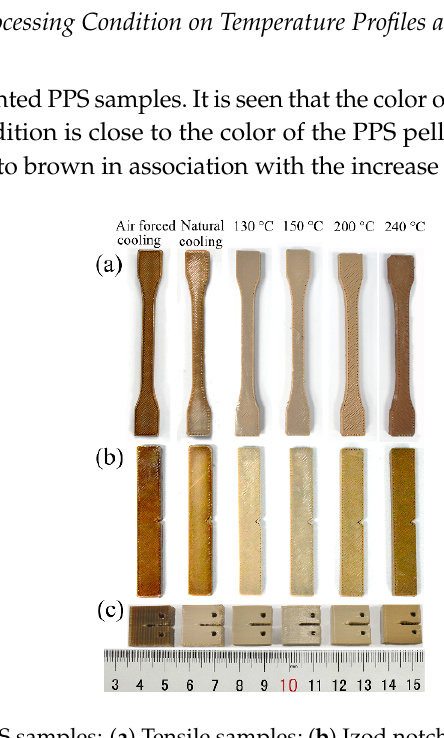
Figure 6. 3D-printed PPS samples: ( a ) Tensile samples; ( b ) Izod notched impact samples; ( c ) compact tensile